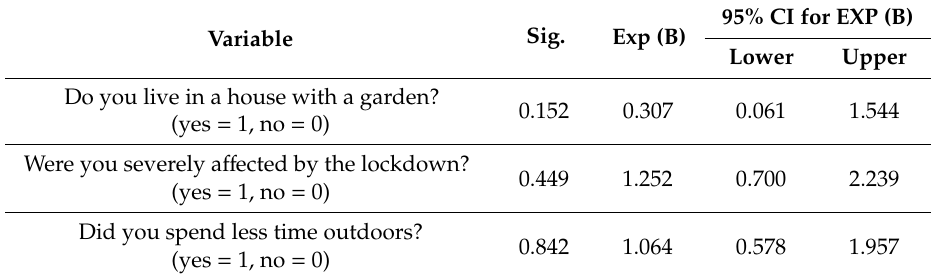
Table 5. The chance of deteriorating sleep quality in relation to changed life conditions as a result of the pandemic. 95% CI for EXP (B) Variable Sig. Exp (B) Lower Upper Do you live in a house with a garden? 0.152 0.307 0.061 1.544 (yes = 1, no = 0) Were you severely a ff ected by the lockdown? 0.449 1.252 0.700 2.239 (yes = 1, no = 0) Did you spend less time outdoors? 0.842